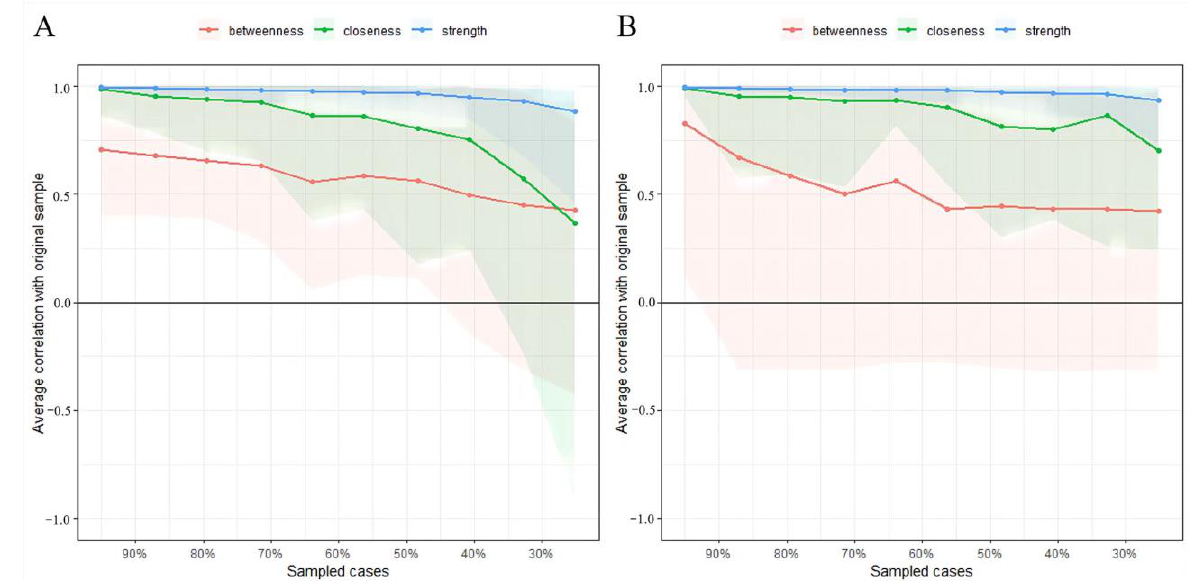
Figure 4. Stability of centrality indices by case dropping subset bootstrap. Note, the x-axis represents the percentage of cases of the original sample used at each step. The y-axis represents the average of correlations between the centrality indices from the original network and the centrality indices from the networks that were re-estimated after excluding increasing percentages of cases. Each line indicates the correlations among betweenness, closeness, and strength. ( A ), wave 1. ( B ), wave 2.